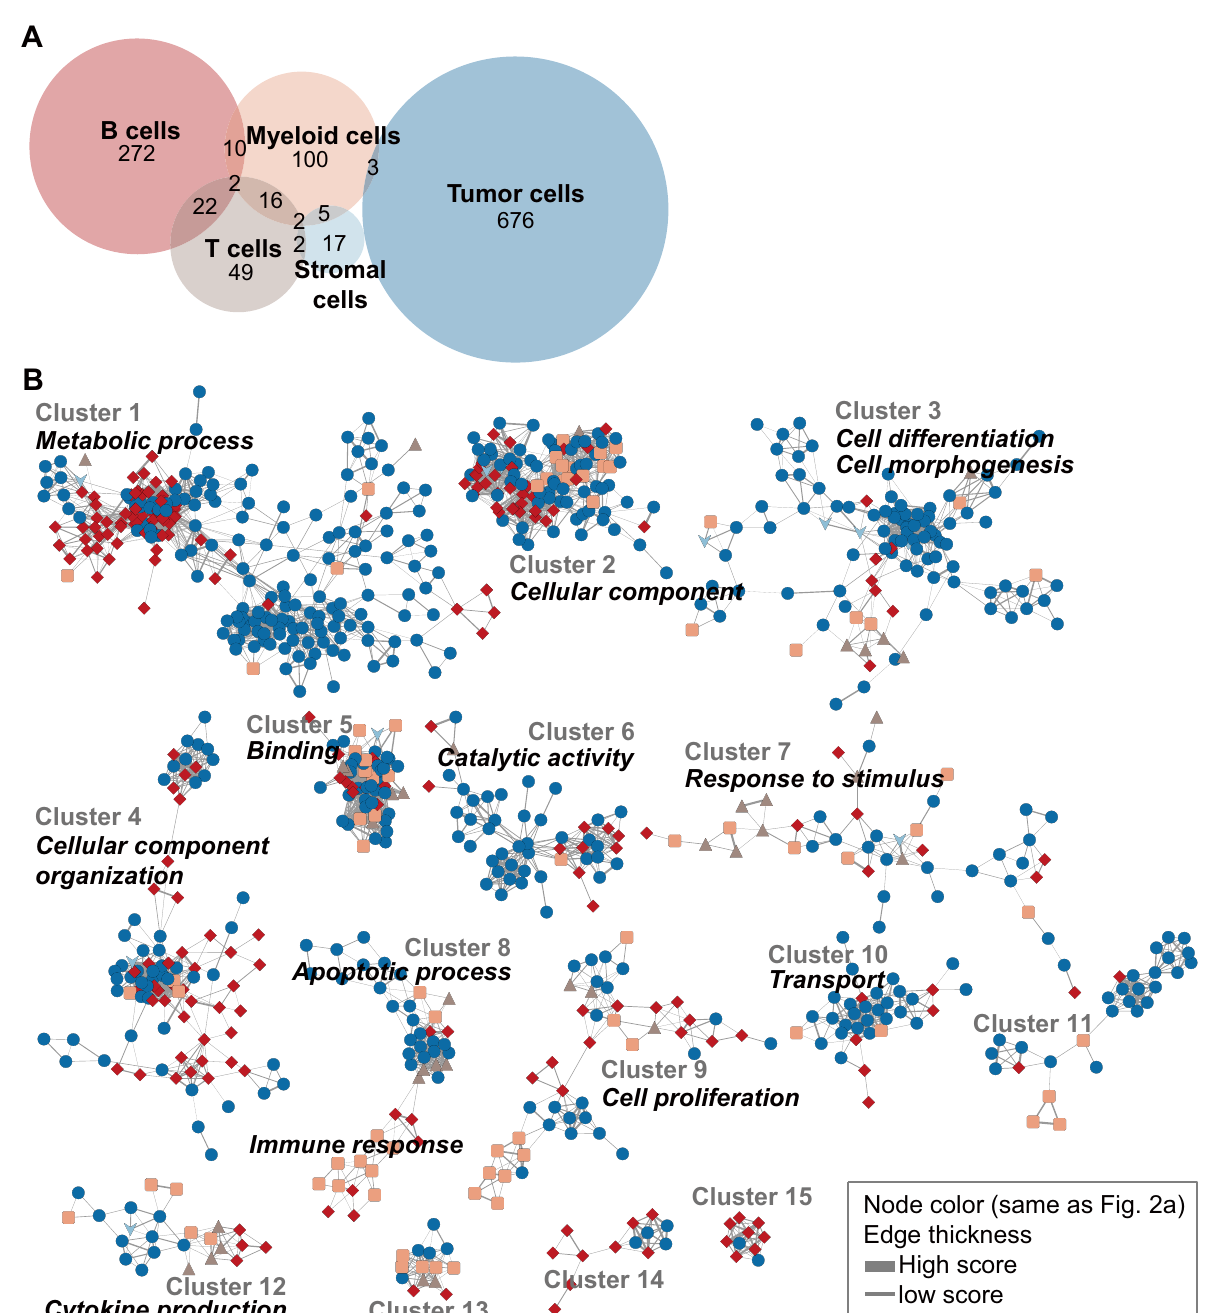
Fig 2. Cell type-specific functional categories associated with 3’UTR shortening and overexpression. (A) Venn diagram for 1,176 gene set hits specific to 5 cell types. Cell type specific gene sets were selected by correlation coefficient and odds ratio. (B) Network-based functional analysis of the selected gene sets. A total of 906 gene sets with sufficient interactions ( > 0.5 Jaccard index and > 9 gene sets in a cluster) were selected for display. The cluster annotations of each gene set are available in S2